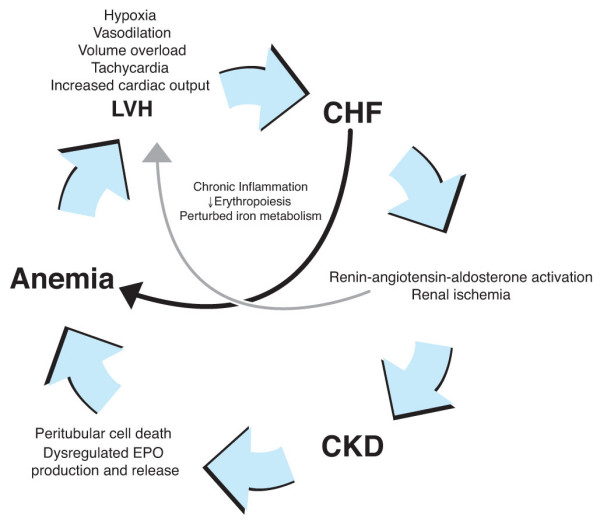
The cardiorenal anemia syndrome. Congestive heart failure (CHF) is a cause and consequence of CKD. First, CHF inflames the heart, liver, and vasculature, creating an influx of circulating cytokines that depress erythropoiesis and perturb iron metabolism [44]. Second, CHF directly induces kidney damage, in which GFR can deteriorate by as much as one mL/min/month [45–47]. In response to reduced cardiac output, blood pressure (and renal perfusion) is maintained by activation of the renin-angiotensin-aldosterone system. Angiotensin II-mediated renal vasoconstriction and increased metabolic demands of the kidney result in renal ischemia and ultimately tubular cell death [1]. Renal cell death in turn hastens anemia through loss of endocrine function. In addition, aldosterone-induced salt and water retention leads to an increased pre-load on the heart, which increases its rate in an attempt to increase output.